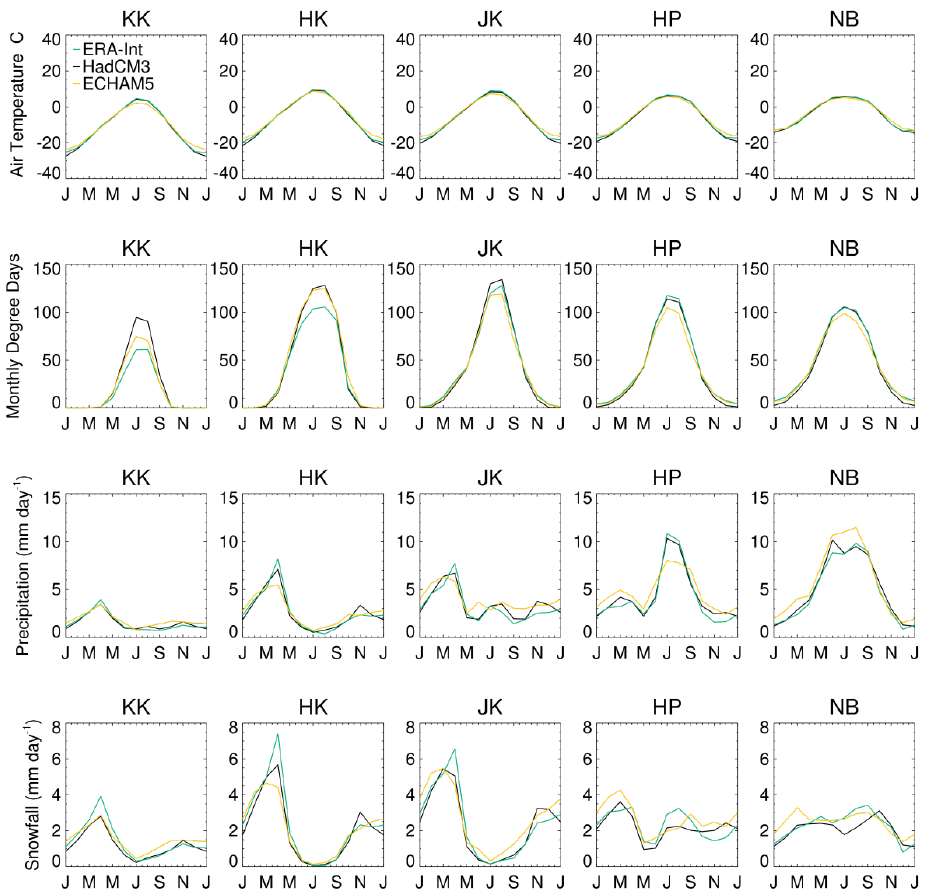
Figure 6. Thirty-year mean climatologies of air temperature, PDDs, precipitation and snowfall for the five sub-regions defined in this study from the downscaled ERA-Interim (green), HadCM3 (black) and ECHAM5 (yellow) simulations for 1992–2008. The regions are Hindu Kush (HK), Karakoram (KK), Jammu–Kashmir (JK), Himachal Pradesh, Uttarakhand and West Nepal (HP) and East Nepal and Bhutan (NB).